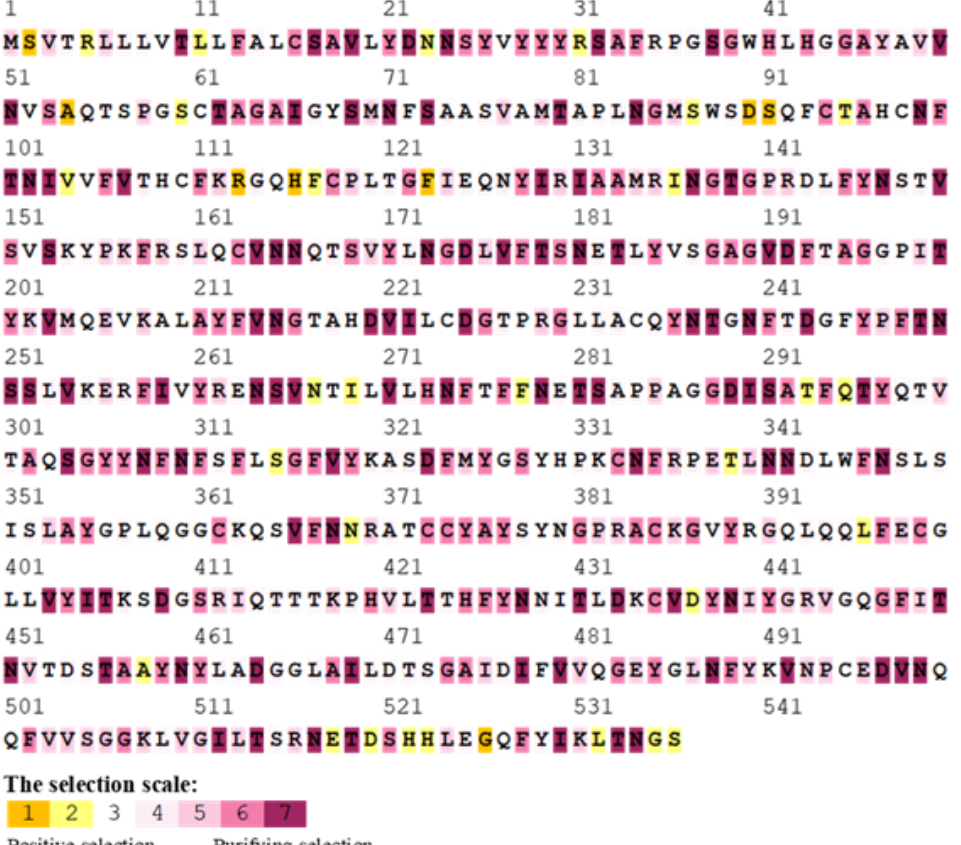
Figure 3. The MEC model in the SELECTION server was used to detect the selective pressure for the aa sequences alignment of S1 glycoprotein for 9 DMV/1639 IBVs, including IBV/Ck/Can/2558004. The aa residues colored with orange to yellow refer to a positive selection, while the residues highlighted with white and gray are indicative of a neutral selection. The purifying selection is represented by a purplish color.